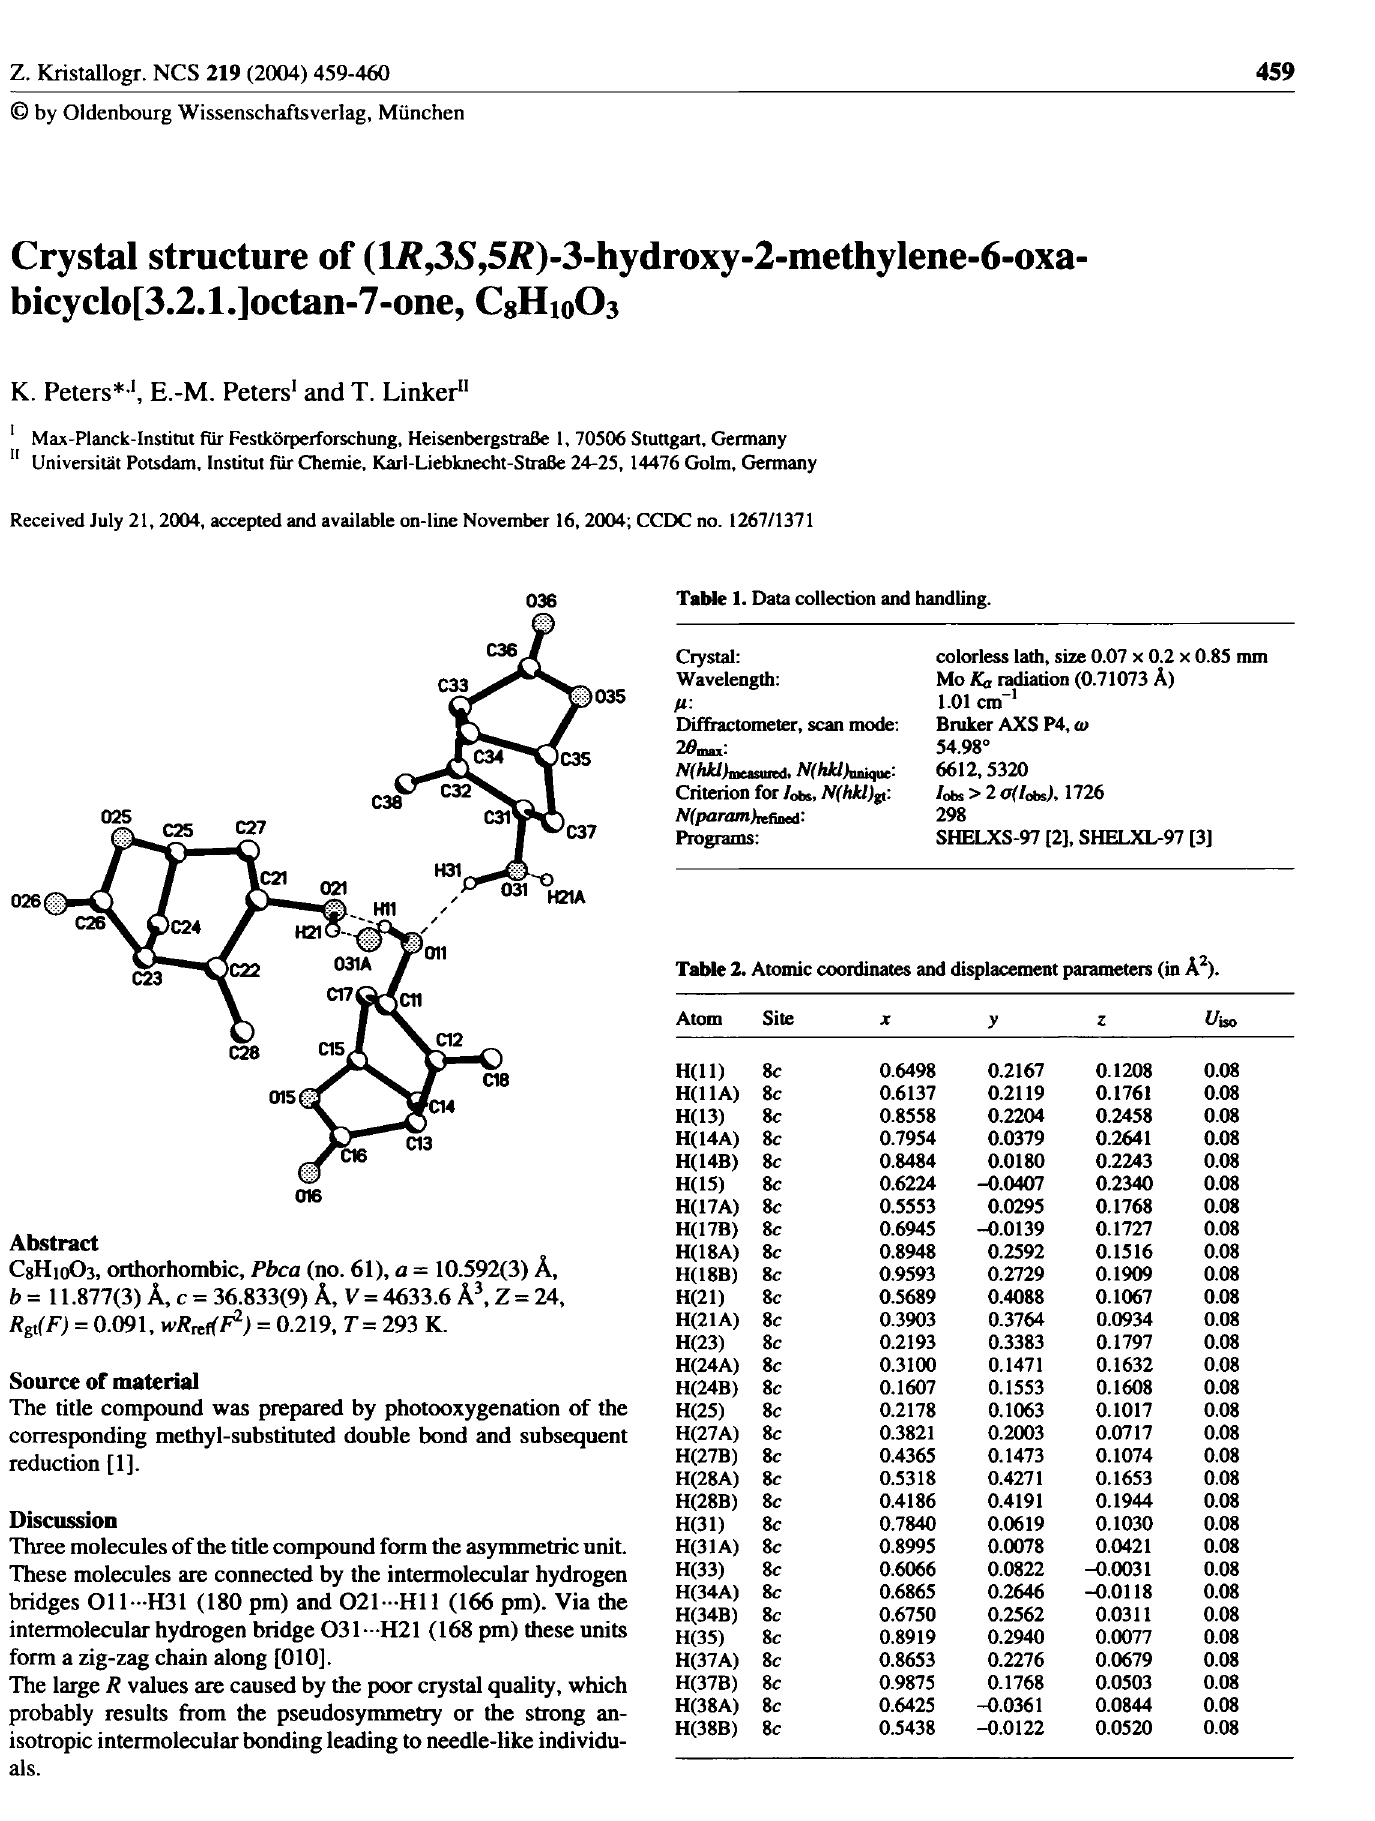
Table 2. Atomic coordinates and displacement parameters (in Â 2